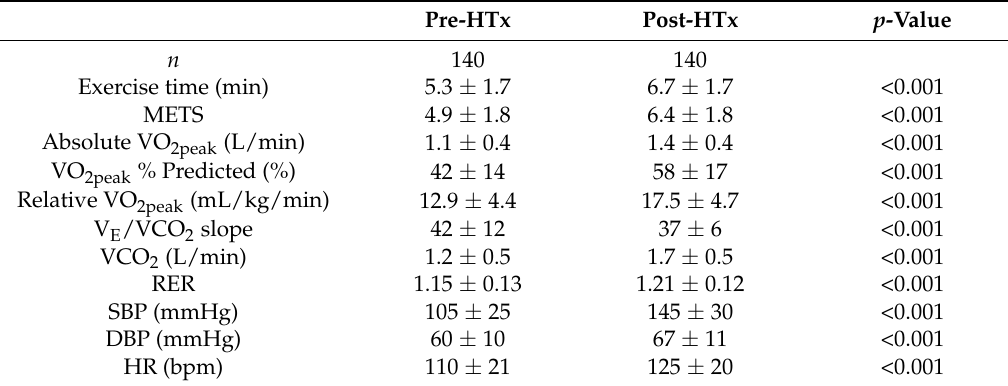
Table 2. Peak exercise testing values prior to and following cardiac transplantation.